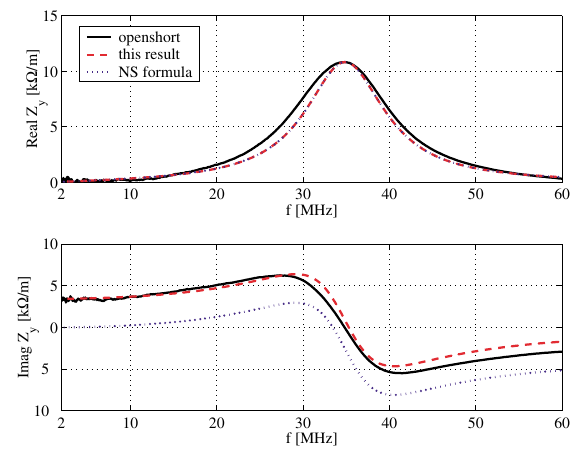
FIG. 7. (Color) Comparison of measurements with improved model and NS